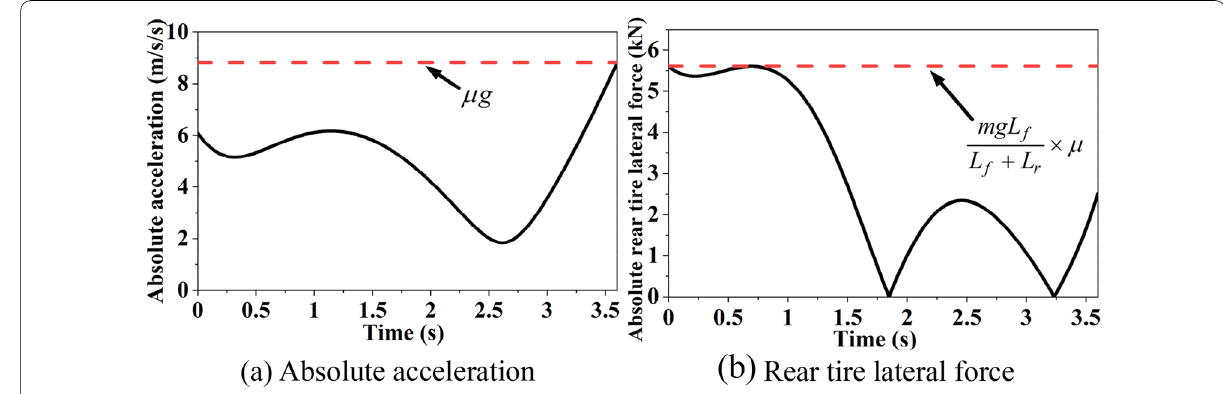
Figure 9 The constraint satisfaction analysis in motion